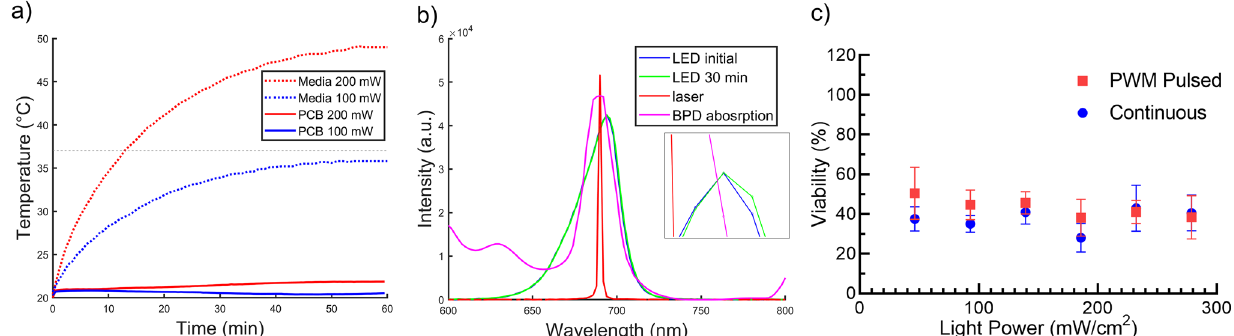
Figure 4. LED spectral stability and maximum irradiance in cell culture 96-well plates to avoid sample overheating and to obtain optimal PDT efficacy. ( a ) The measured temperature of cell culture media within the sample well plate (dotted) and the LED array PCB (solid) over time during the 60-min illumination test period, for a test run at 100 mW/cm 2 (blue) and at 200 mW/cm 2 (red). A line at the standard 37 °C incubation temperature (dashed grey) is included as a reference. ( b ) The output spectrum of the LED array before (blue) and after (green) a 60-min, 200 mW/cm 2 illumination protocol. The spectrum is stable over the 1-h test period with only a sub-nanometer shift in peak wavelength visible in the zoomed inset. The spectrum of the 690 nm laser (red) and the BPD absorption spectrum (magenta) are also included for comparison. ( c ) Viability of the OVCAR3 cells after a n 8 J/cm 2 PDT treatment with different